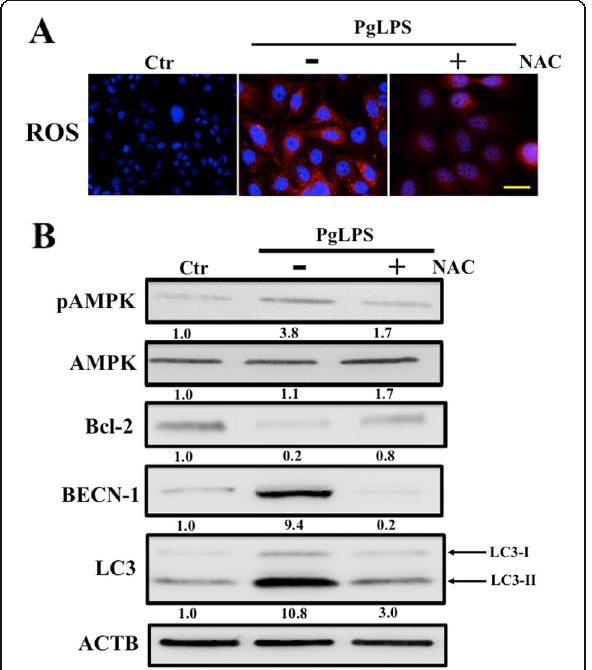
Fig. 6 Intracellular reactive oxygen species (ROS) production regulates PgLPS-induced autophagy. HaCaT cells were either treated with 10 μ M PgLPS alone or 10 μ M PgLPS plus 100 μ M N-acetylcystein (NAC) for 24 h. Cells treated with medium alone were control (Ctr). a Representative fluorescence images are shown to demonstrate an intracellular ROS production (red) using CellROX reagents. Nuclei were stained with Hoechst 33324 (blue). Bar=50 μ m. b Western blotting assay was performed with beclin-1 (BECN-1), or LC3. β -actin (ACTB) was used as a loading control. (normalized to ACTB) and compared with the results for untreated cells (Ctr). Quantification results are shown below the corresponding